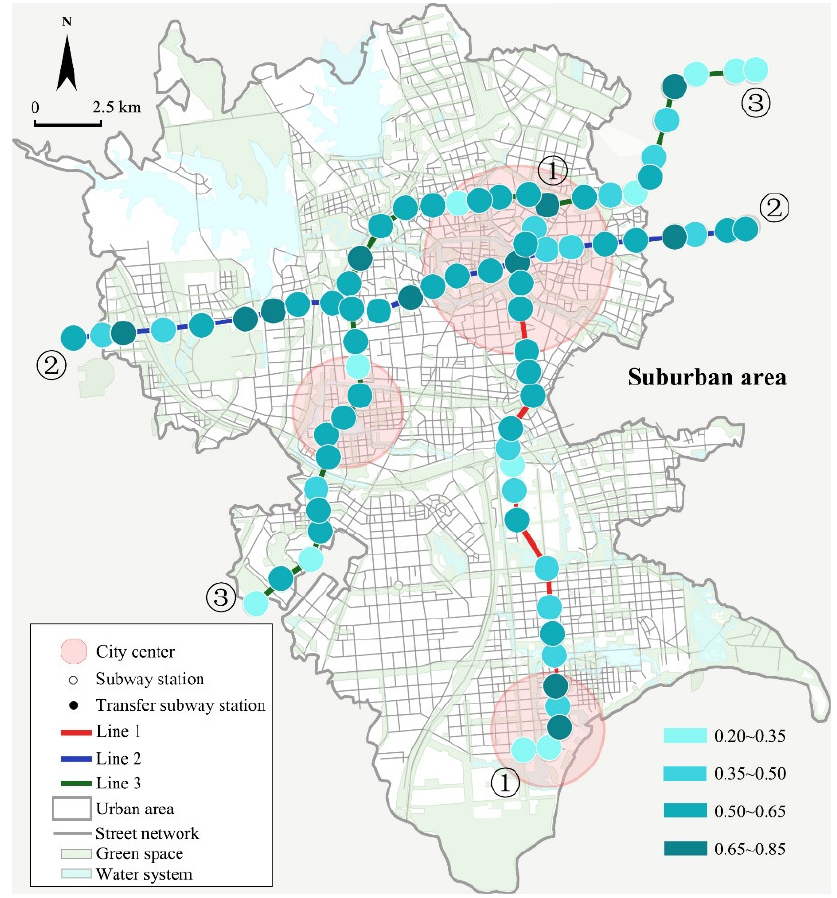
Figure 6. Map of place-values in Hefei City.